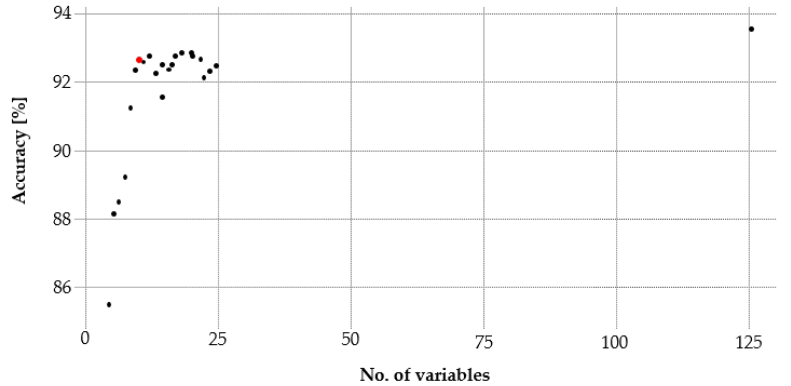
Figure 4. The Recursive Feature Elimination (RFE) identifies a set of 11 variables (red dot) that met the suitable accuracy of